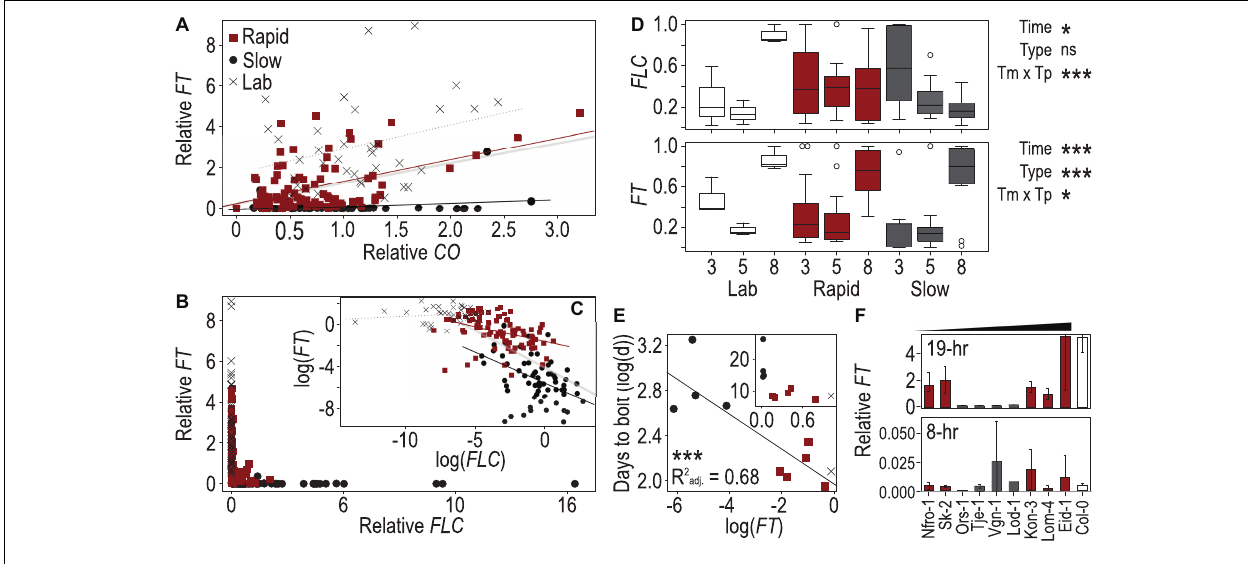
FIGURE 2 | The behaviors of FLOWERING LOCUS T ( FT ), CONSTANS (CO), and FLOWERING LOCUS C ( FLC ) genes vary across accessions and correlate with flowering time. (A–C) Correlations between FT and CO (A) and between FT and FLC (B,C) across the Arabidopsis accessions used in this study. Lines from winter-annual accessions collected from Norway and classified as rapid flowering (red) or slow flowering (black), while summer-annual “lab” accessions are shown in gray. All points correspond to a single plant grown in one of three biological replicates and harvested at 1, 9, 13, 17, 20, or 24 h after onset of photosynthetically active radiation (PAR, “dawn”). The log-linearized values for FT and FLC are plotted in panel (C) . The thick gray line (A,C) indicates the linear trend across all points and accessions, while the other trendlines are specific to flowering type: rapid (red), slow (black), lab (dotted, gray). Values were normalized to the average per replicate before comparing across replicates. (D) Change in FT and FLC expression in plants harvested at 17 h after dawn across days 3, 5, and 8 post vernalization in the rapid, slow, and lab accessions. Relative expression values were normalized to the maximum value within each strain to enable comparison of the change in expression over time. Boxes represent the span between the first and third quartiles, while the middle line represents the median in each group. Asterisks indicate significance of time, flowering type, or their interaction in an ANOVA ( *p < 0.05, *** p < 0.0001, ns = not significant). (E) Correlation between mean days to bolt for each strain and mean FT expression across three biological replicates from plants harvested 17 h after dawn on day 8 after vernalization. Values were log-linearized; inset shows non-transformed data. Asterisks indicate a significance of p < 0.0001. Colors indicate rapid, slow, or lab accessions as shown in panel (A) . (F) FT from plants harvested 5 days after vernalization close to the end of the light period 17- and 9-h after dawn and grown in 19- (top) and 8-h (bottom) photoperiods, respectively. The winter-annual accessions are organized by least to greatest difference in DTB between the two treatments. Due to limited resources, only Col-0 was included in panel (F) . In all cases (A–F) , gene expression was relativized to house-keeping genes prior to any other